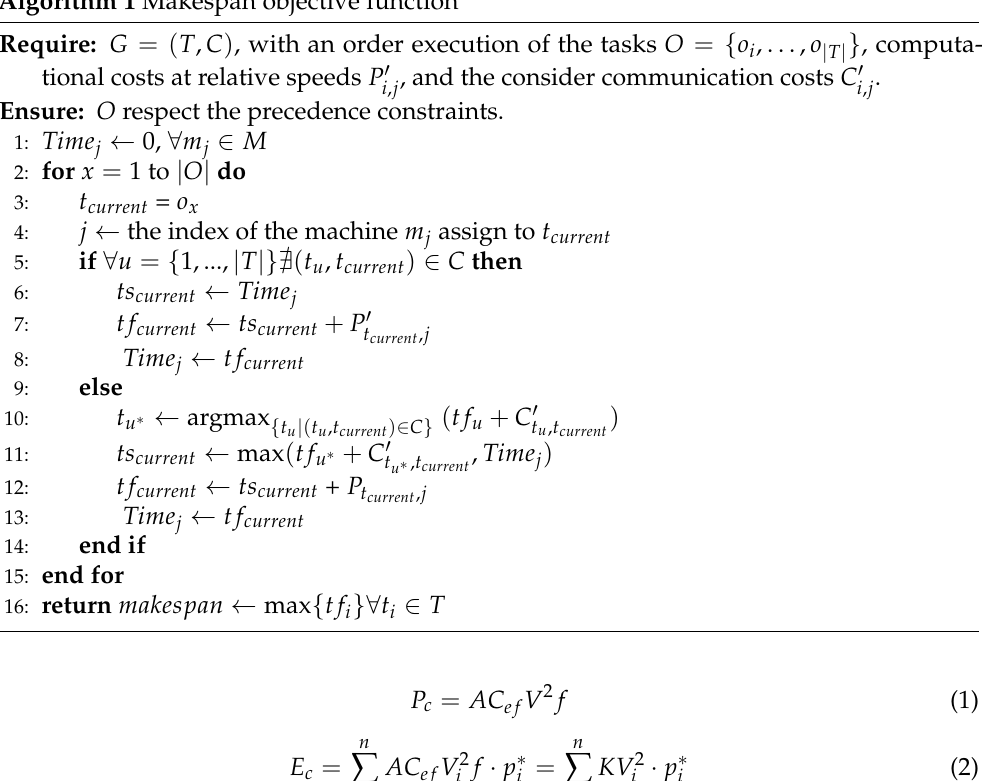
Algorithm 1 Makespan objective function